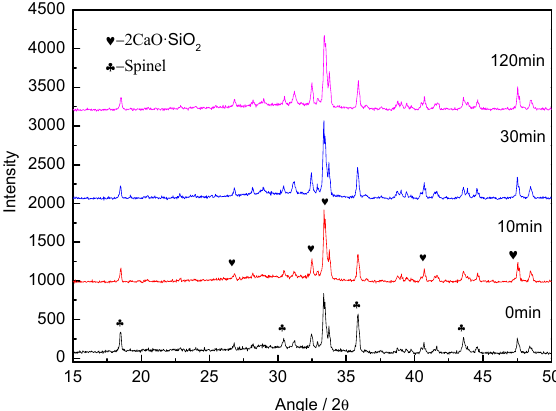
Figure 2. Effect of heat treatment time on the XRD diffraction pattern of the slag samples at 1450 °C. The microstructures of the slag samples observed by SEM-EDS are shown in Figure 3. There were three kinds of mineral phases in all samples: (1) the white and regularly shaped phase is the spinel crystal, (2) the black striped phase is the α -C 2 S phase, and (3) the hoar phase is the glassy matrix. The proportion of spinel phase with respect to the other phases remained nearly stable for all of the executed treatments.